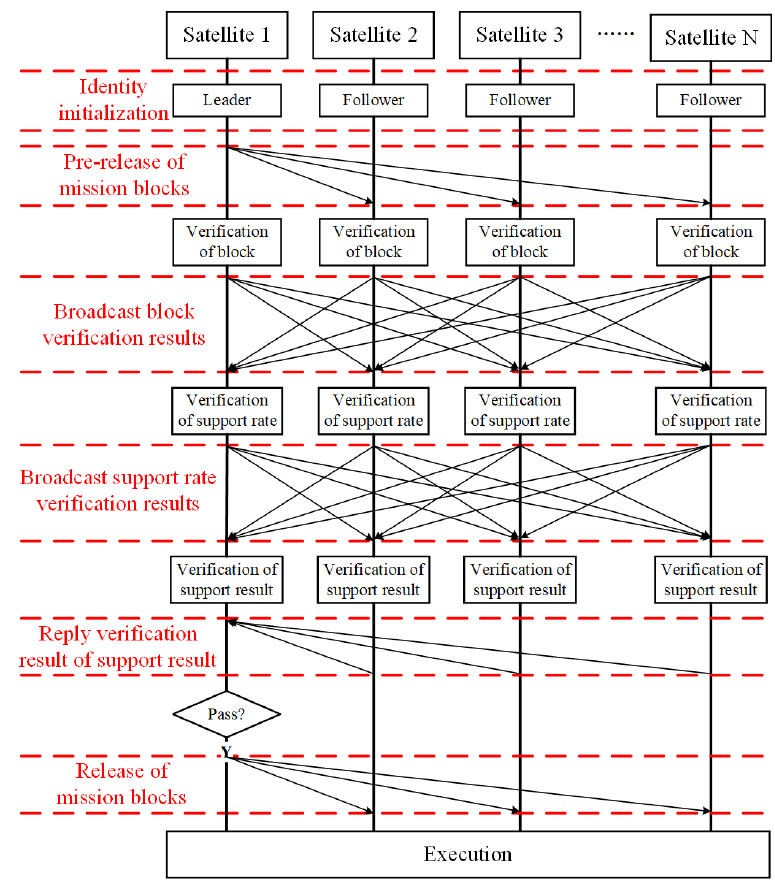
Figure 4. Algorithm flowchart of PBFT.